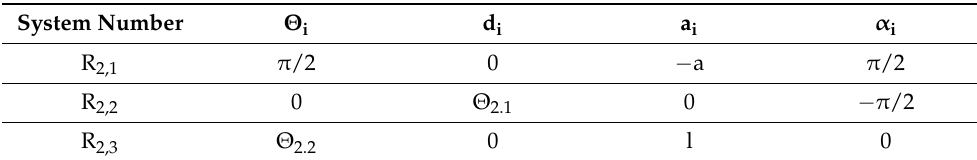
Table 2. The parameters and kinematic variables of a plane manipulator with two degrees of freedom second arm (lower).